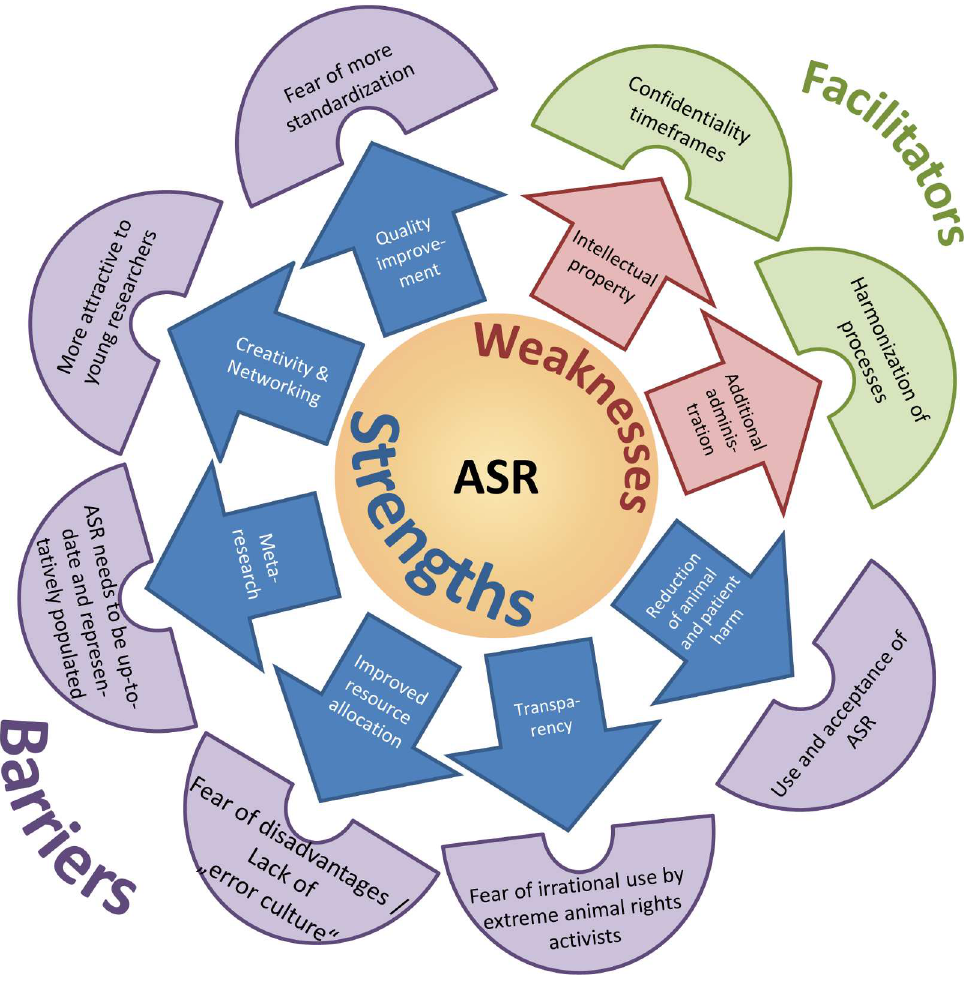
Fig 1. Visualization of core